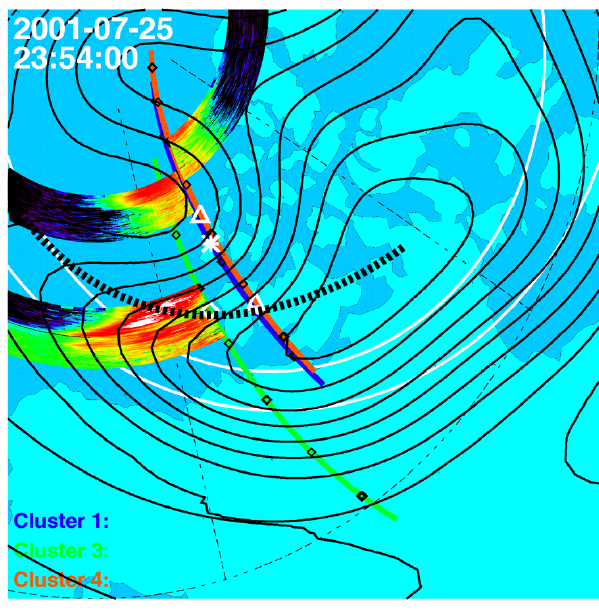
Fig. 6. Composite plot of Cluster magnetic footpoints and iono- spheric convection streamlines for 25 July 2001, at 23:37UT. Over- layed on the magnetic footpoints are 14-min wide sections of the Cluster/CIS flux measurements presented in Plate 1, which are cen- tered on the actual position of the Cluster satellites at 23:37UT. The original entry point of SC1 and SC4 into the cusp are marked with a star and a triangle along the tracks of their magnetic foot- points. SC1 and SC4 are deep inside the cusp and have just entered the dawn convection cell, which resulted in an almost simultaneous sudden increase in the ion energy dispersion on both satellites, as expected from a spatial interpretation of the cusp structures. At that time SC3 was still on closed field lines.